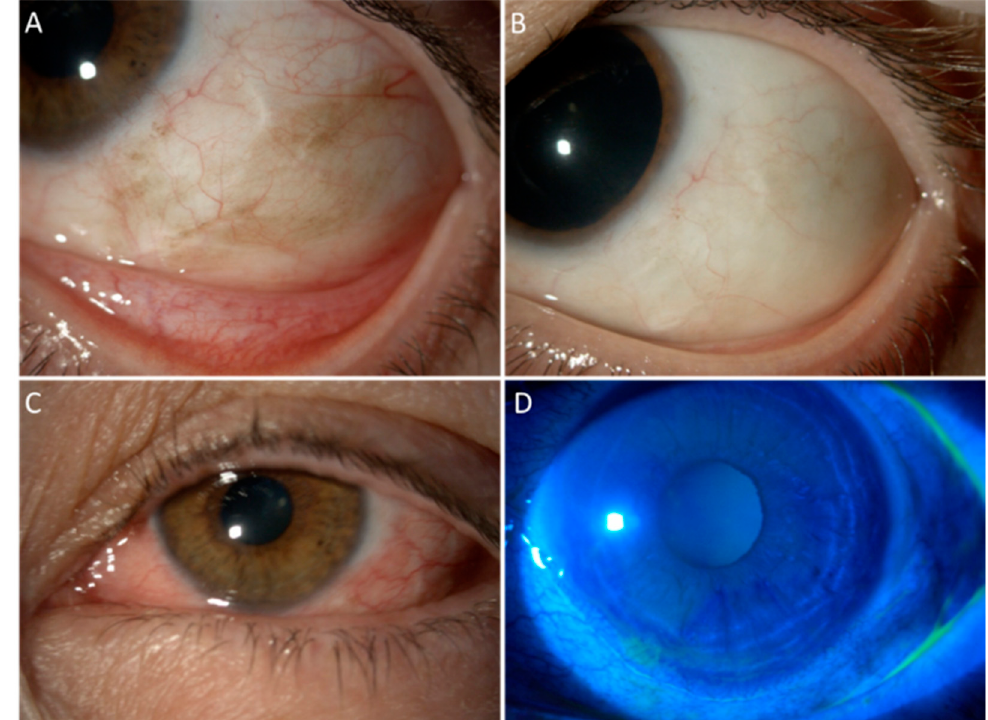
Figure 1. An example of MMC toxicity that successfully resolved with the treatment. A 54-year-old female suffering from biopsy-proven enlarging PAM with moderate atypia in the left eye, which had already been treated with surgical excision and conjunctival graft 8 years earlier for localized PAM with severe atypia. Part ( A ): Slit lamp picture at baseline, with tumour recurrence surrounding the paralimbal scar of the previous surgery. Part ( B ): Complete disappearance of pigmented cells 2 years after four courses of MMC 0.02% (one drop QID for 7 days). Part ( C ): Allergic reaction to MMC starting from the second cycle of treatment, presenting with lid edema, conjunctival swelling, epiphora, and photophobia. Part ( D ): Fluorescein staining revealed a peripheral superficial corneal epithelial defect. The allergic reaction has been managed with cold compresses, artificial tears, vitamin A ointment, and suspension of MMC. Once the epithelium was completely healed, MMC has been started again in association with weak steroid eye drops and close surveillance.